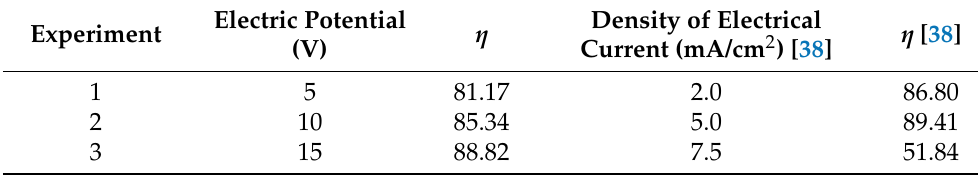
Table 9. Comparative data of Electrical efficiency ( η